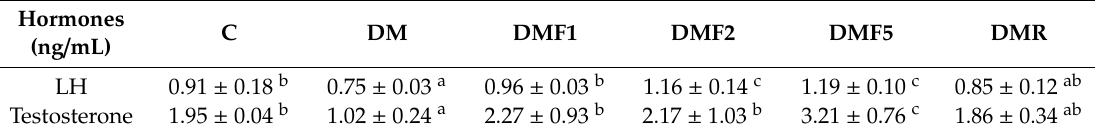
Table 4. E ff ect of fucoxanthin on reproductive hormones value of rat plasma after treatment for four weeks.